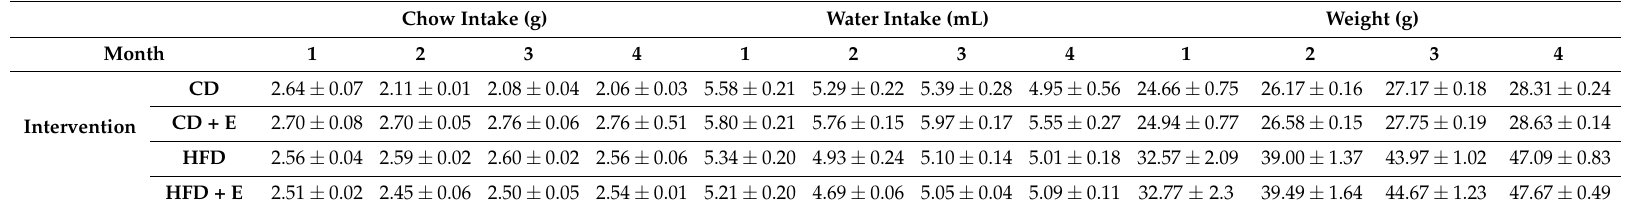
Table 2. Body weight, food and water intake of C57BL/6J male mice over a period of four